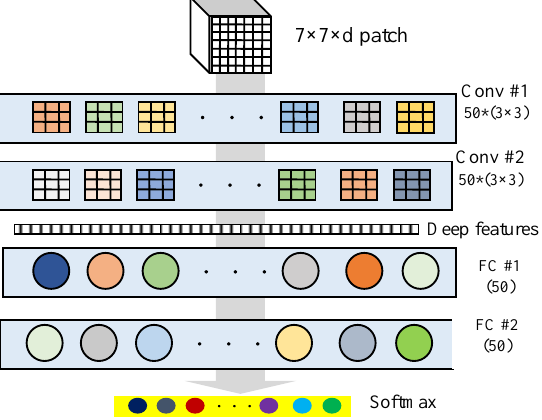
Figure 5. Architecture of the optimum network based on the results of Table